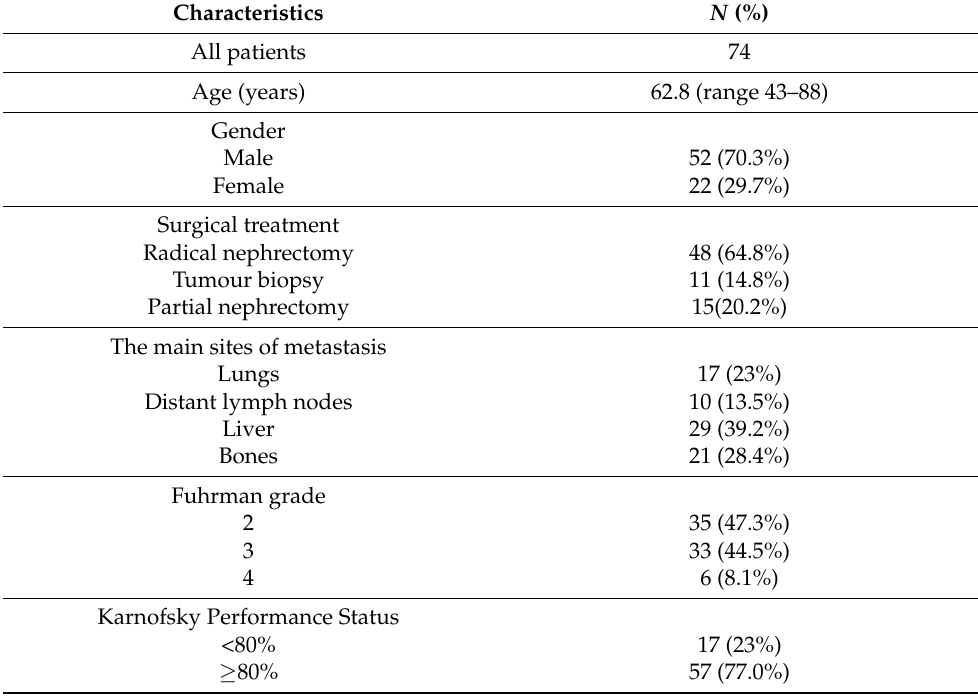
Table 1. The clinical–pathological